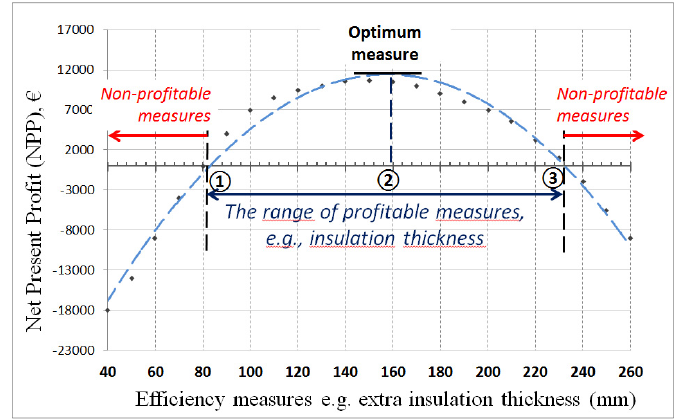
Figure 6. Net present profit concept for the cost ‐ optimal level and cost ‐ effectiveness analysis of energy renovation measures.